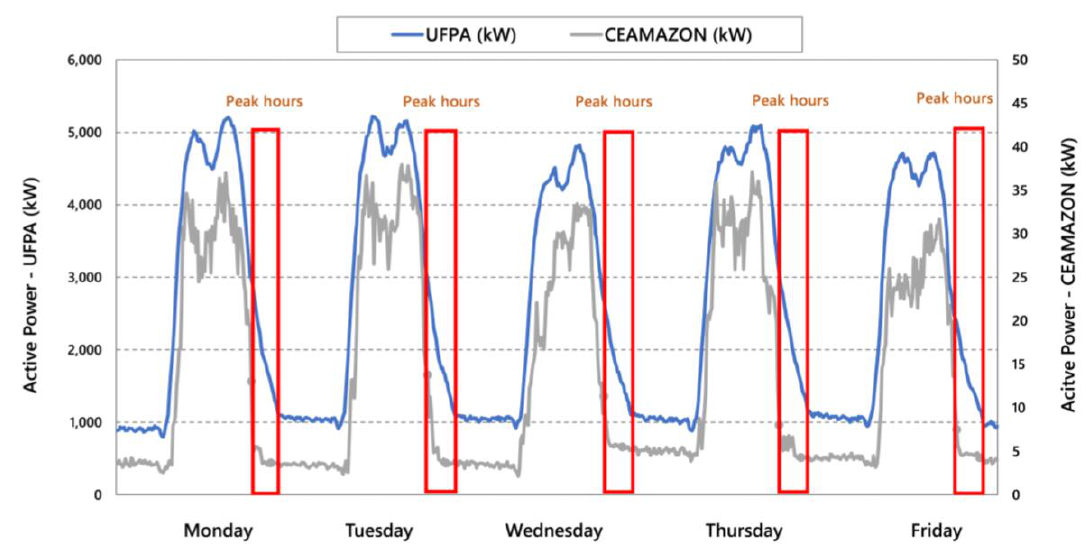
Figure 8. Energy demand at UFPA and CEAMAZON.